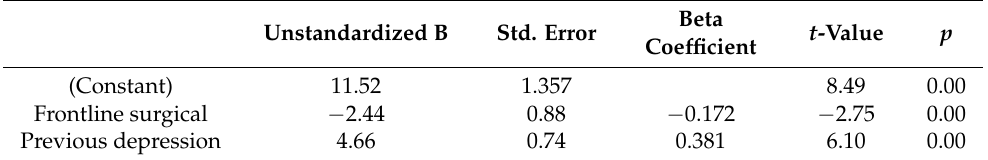
Table 5. Predictive model for PHQ-9 scores.